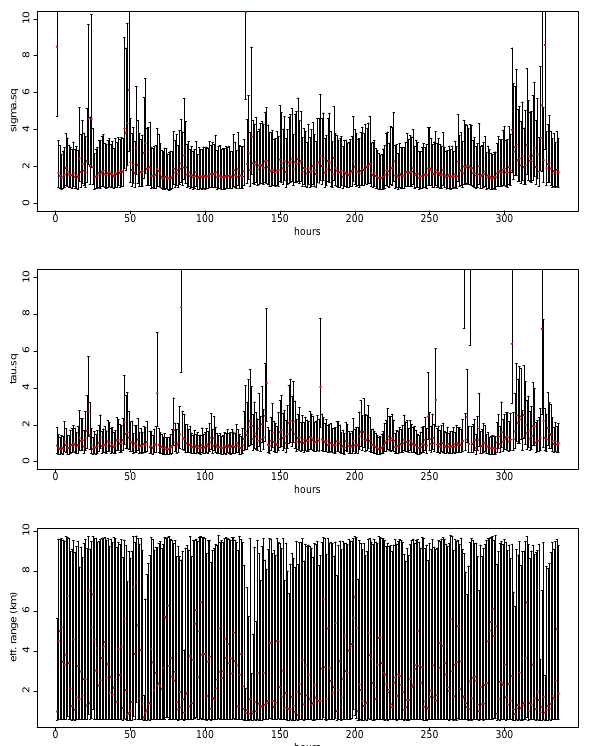
Figure 3. Variation in σ 2 t (top), τ 2 t (middle), and 3 /φ (effective range) (bottom) over time (median and 95% credible interval).